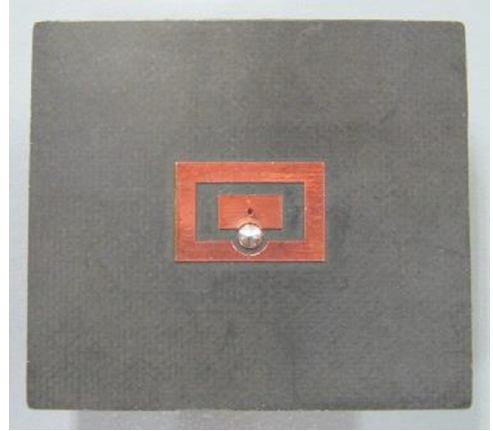
Fig. 7. Photograph of wide beamwidth antenna